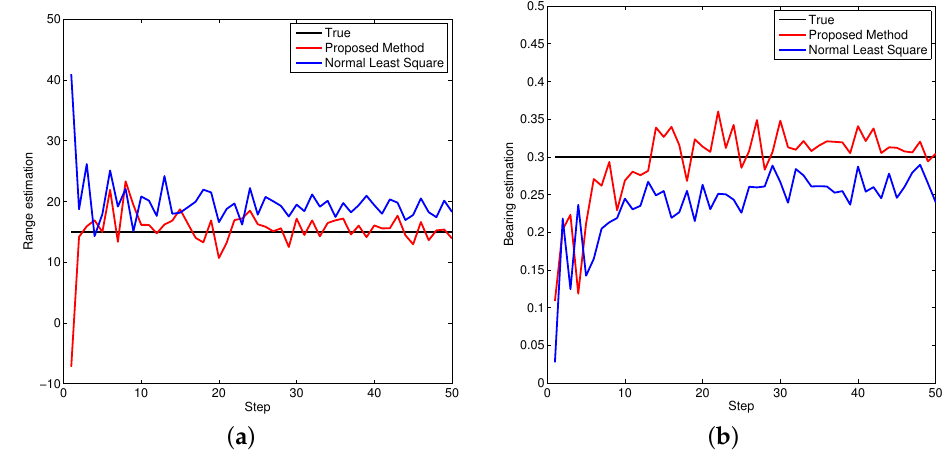
Figure 6. Bias estimations for object two. ( a ) Bias estimation in range; ( b ) Bias estimation in bearing.